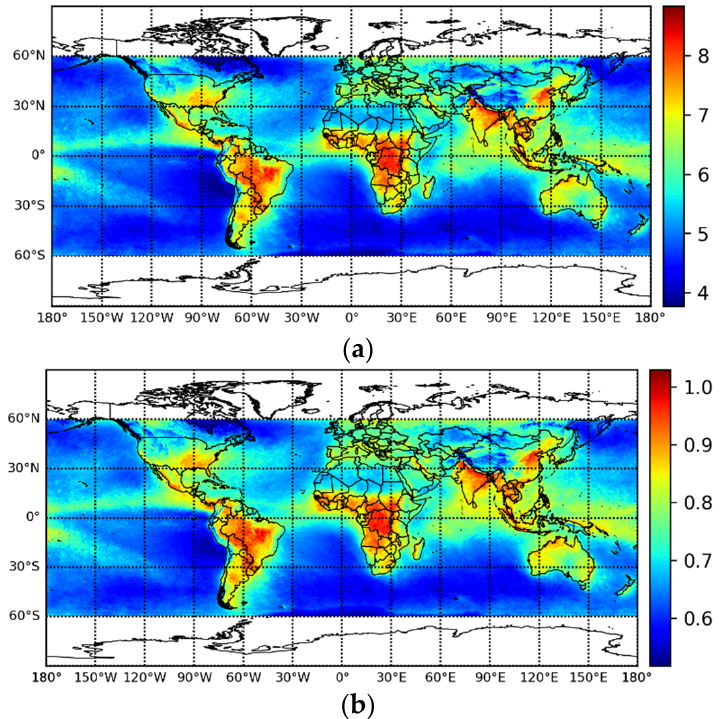
Figure 10. ( a ) Distribution of upper bound from 90% surface concentration estimation. ( b ) Distribution of lower bound from 90% surface concentration estimation. (unit: μ g/m 3 ).